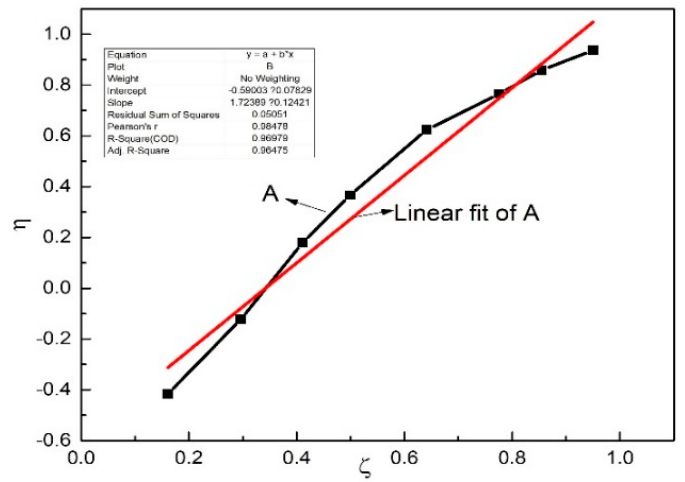
Figure 11. The η - ζ curve of agglomeration rate of the butadiene-isoprene copolymers. As shown in Figure 11, the datapoints obtained at different Bd:Ip mole ratios followed a saturation curve. The straight line obtained from the η - ζ curve can represent the equation Y = 1.72 X − 0.59. It can be comprehended from the straight line that the slope and intercept are r 1 + r 2 · a − 1 and − r 2 · a − 1 , respectively. The reactivity ratios of the butadiene monomer and isoprene monomer are r 1 = 1.13 and r 2 = 0.31 respectively, where r 1 > 1 indicates that the butadiene monomers tend to homo-polymerization, r 2 < 1 indicates that the isoprene monomers tend to copolymerize with the butadiene monomers, and r 1 r 2 < 1 conjectures that the reaction is geared to the non-ideal non-constant ratio copolymerization under the catalytic